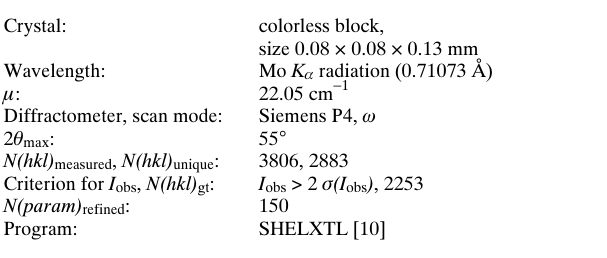
Table 1. Datacollection and handling.